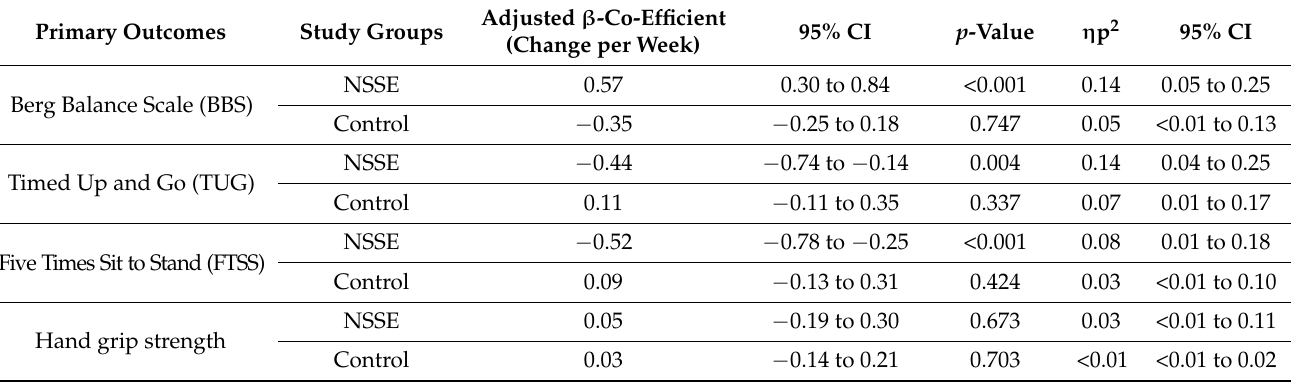
Table 2. Changes in physical performance parameters in the NSSE group and the control group over the 8-week